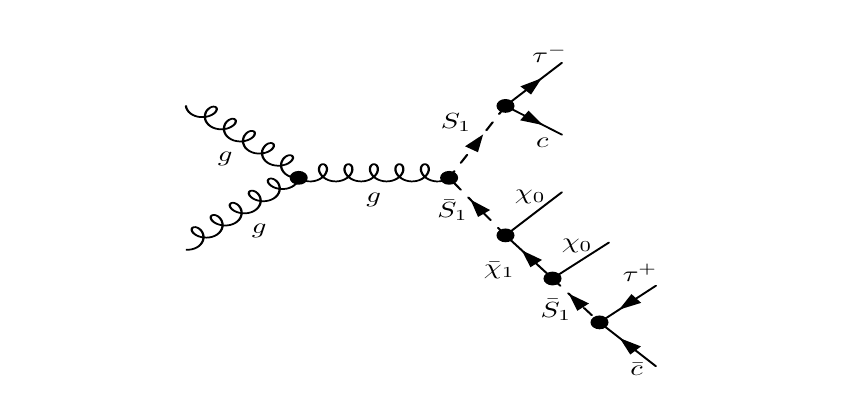
Figure 8 . Exclusion bounds on our model derived from the cττ search [77], presented in the ( λ L , λ R ) plane.